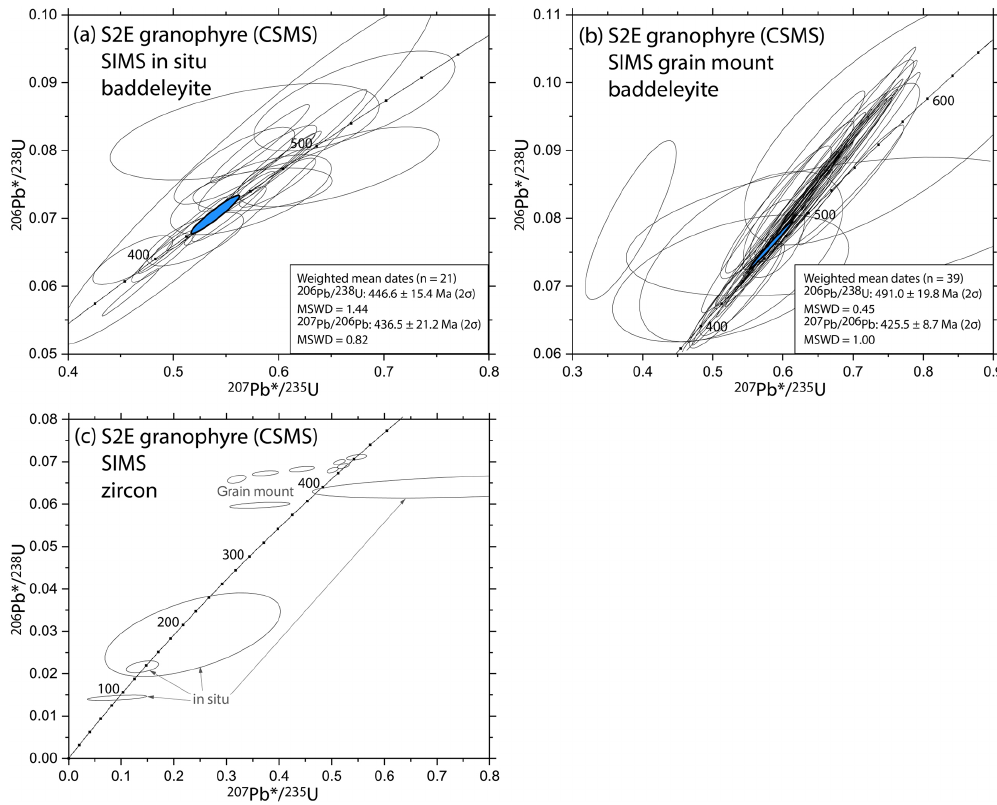
Figure 7. SIMS U–Pb baddeleyite (a, b) and zircon (c) results for CSMS samples. Error ellipses of individual analyses (only those used for weighted mean date calculations are shown) are 1 σ , whereas the weighted mean ellipse (blue) is enlarged to 2 σ